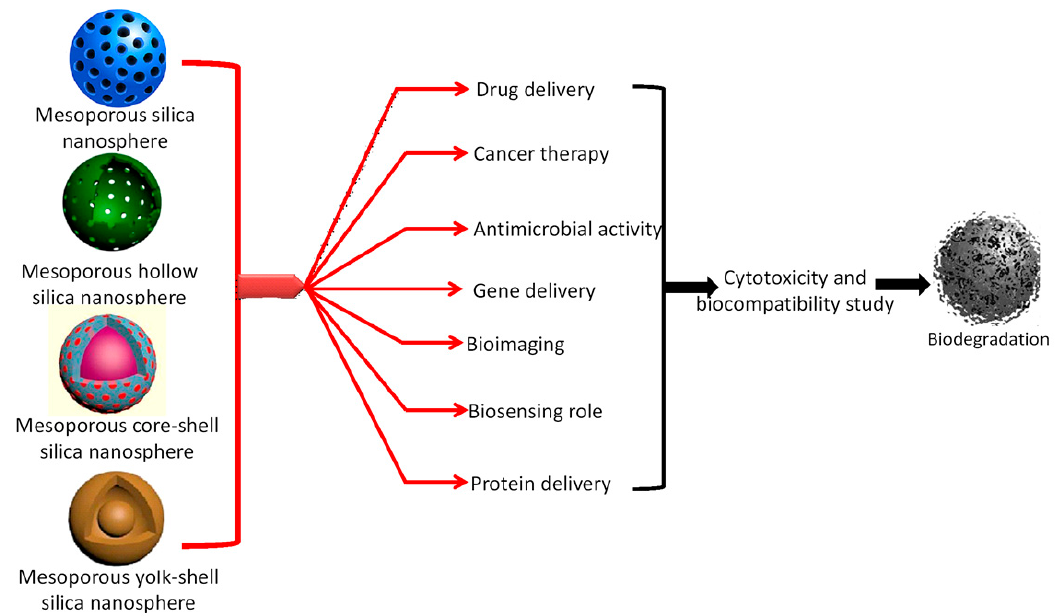
Figure 12. A schematic diagram for various biological applications of morphology oriented porous silica nanoparticles.